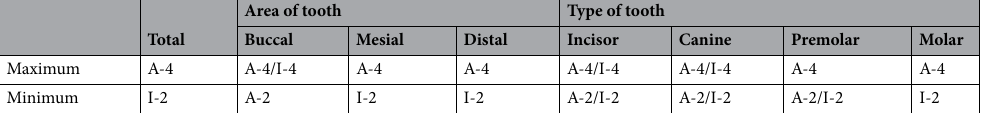
Table 2. Maximum and minimum cleaning efficacy of the I-Prox P brush and the AirFloss Ultra cleaning devices at different application frequencies (two seconds (I-2)/sprays (A-2) vs. four seconds (I-4)/sprays